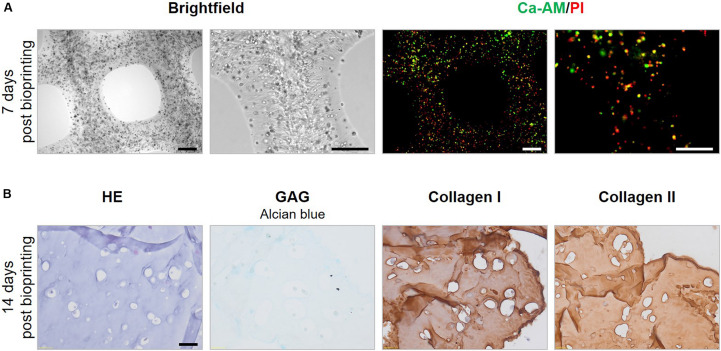
Evaluation of bioprinted single cells. (A) Morphology and viability of bioprinted single cells 7 days post printing. Scale bars 200 μm. (B) HE staining was performed to assess overall morphology, Alcian Blue staining showed the presence of glycosaminoglycans (GAG) and IHC stainings for collagen type I and type II were performed. Scale bar 20 μm.